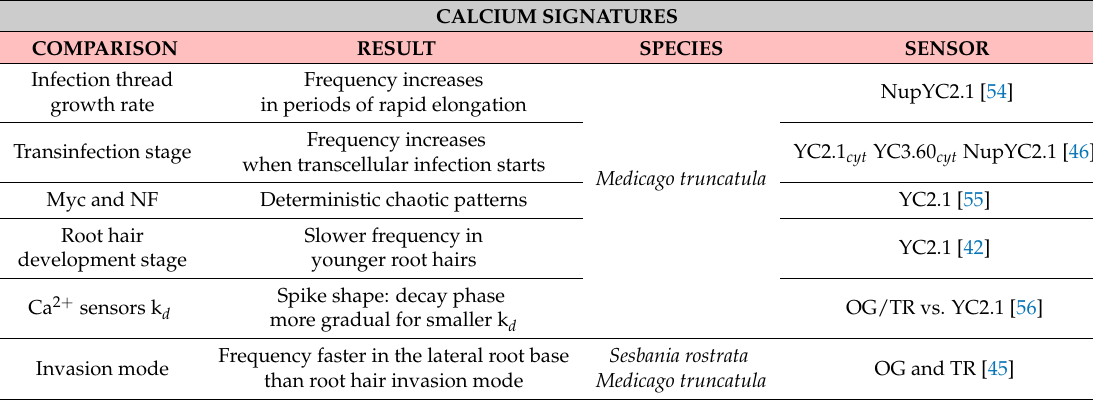
Table 2. Calcium signatures: different Ca 2 + oscillation frequencies or spike shapes characterise different